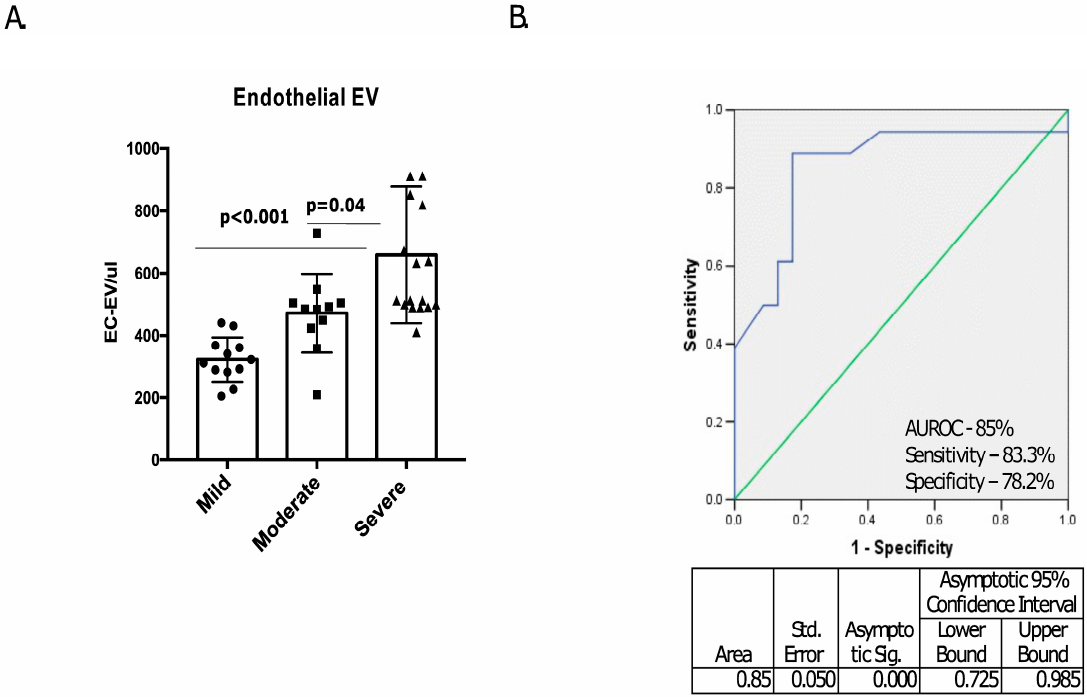
Figure 2. EC-EVs associated with severe intrapulmonary shunting. ( A ) The bar diagram depicts a significant increase in EC-EV levels in severe shunting versus in mild shunting ( p = 0.00). ( B ) ROC analysis with estimation of the corresponding area under the curve (AUC) shows the predictive potential of EC-EVs for cirrhosis with HPS as mild vs. severe.